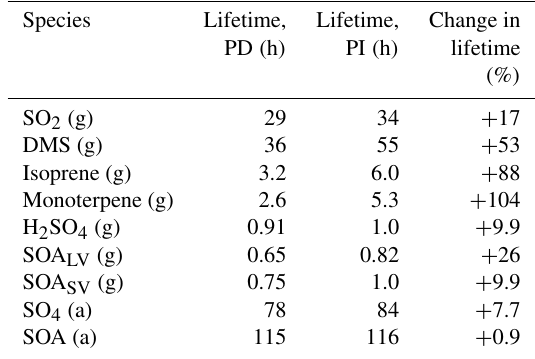
Table 4. Global mean lifetime of different gaseous and aerosol species (g: gas; a: aerosol) when applying PD and PI oxidants in the PI simulation. The lifetime is calculated as (global mean bur- den)/(global mean